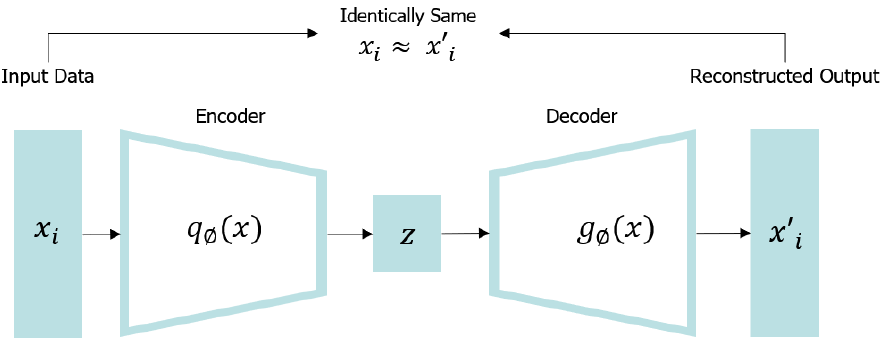
Figure 3. Basic Architecture